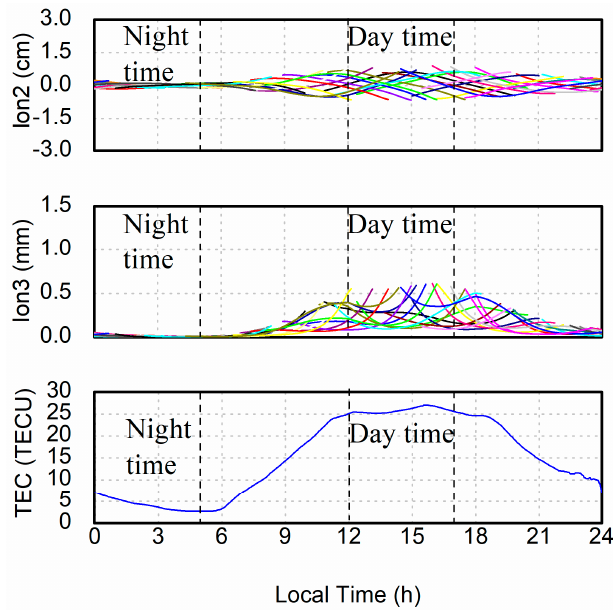
Figure 3. Time series of Ion2 terms (top), Ion3 terms (middle) and vertical TEC (vTEC) (bottom) observed at station YKRO on DOY 239, 2017. The daytime (LT 12–17) and night-time (LT 0–5) are separated by a dashed line.